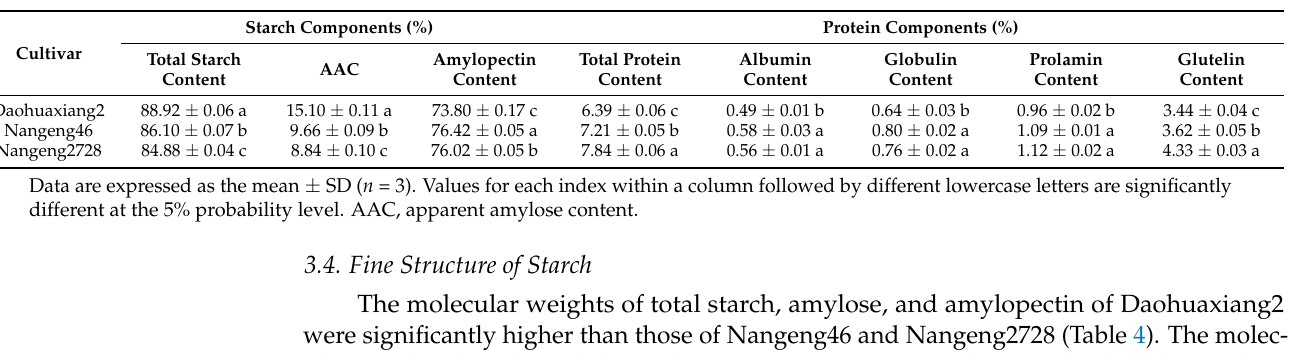
Figure 2. Rheological properties of different japonica rice. Table 3. Differences of chemical components among different japonica